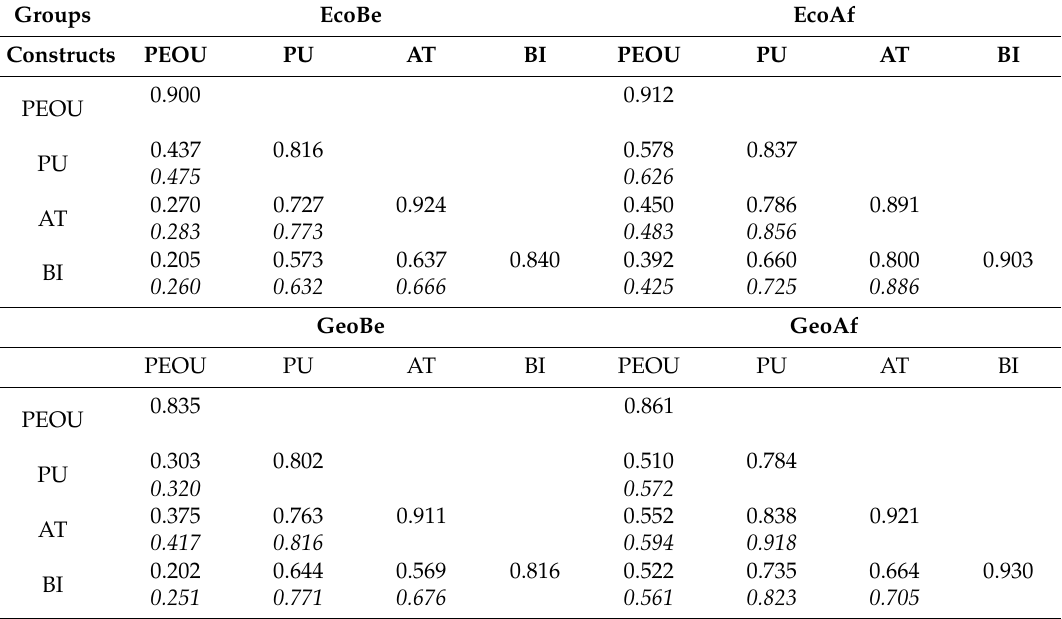
Table4. TheFornell-Larckercriterionandthevariables’correlationmatrixandtheHeterotrait-Monotrait (HTMT)